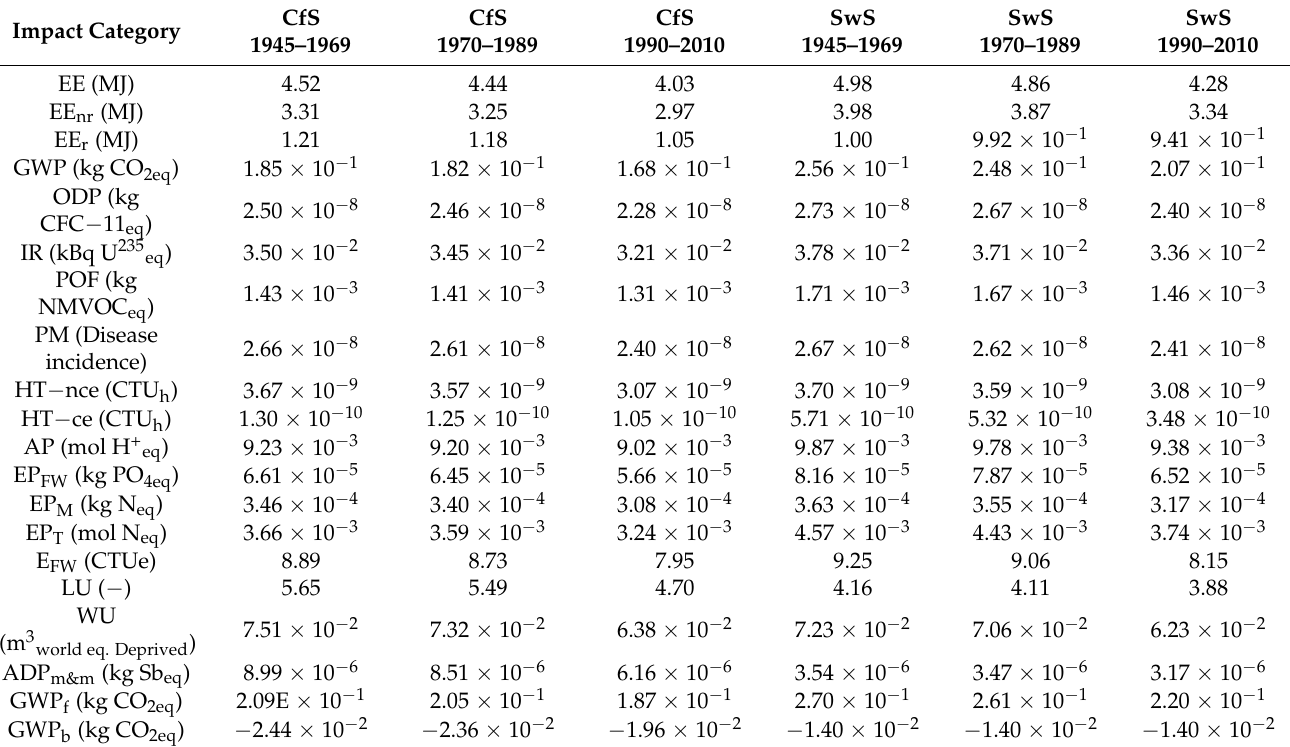
Table 4. LCIA—retrofit action—cellulose fibers (Cf) and stone wool (Sw) scenarios—FUR: 1 m 2 of vertical envelope. Impact